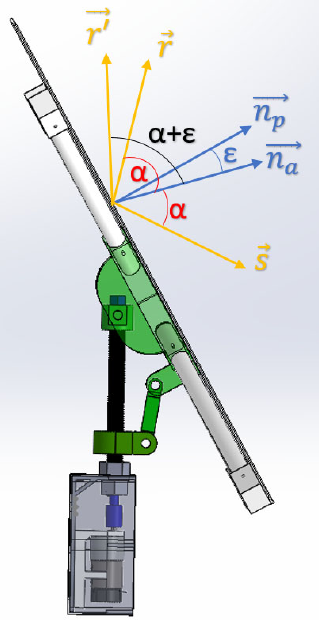
Figure 14. Geometric definition for pointing error ξ .